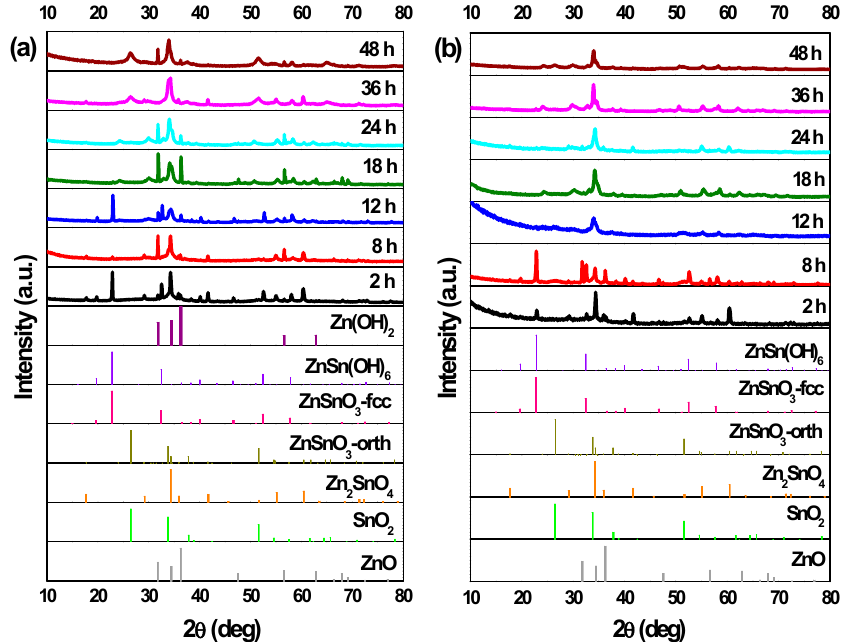
Figure 5. XRD patterns when using ( a ) ZnCl 2 precursor (with 2:1 Zn:Sn ratio) and ( b ) ZnAc precursor (with 1:1 Zn:Sn ratio), for different reaction time: 2 h, 8 h, 12 h, 18 h, 24 h, 36 h, and 48 h. Syntheses at 200 °C, using 15 mL of reaction mixture volume. Identification following ICDD cards: 00-028-1486 (ZnSnO 3 -orth—deleted), 00-011-0274 (ZnSnO 3 -fcc), 00-024-1470 (Zn 2 SnO 4 ), 01-077-0452 (SnO 2 ), 00-06-1451 (ZnO), and 00-048-1066 (Zn(OH) 2 ).